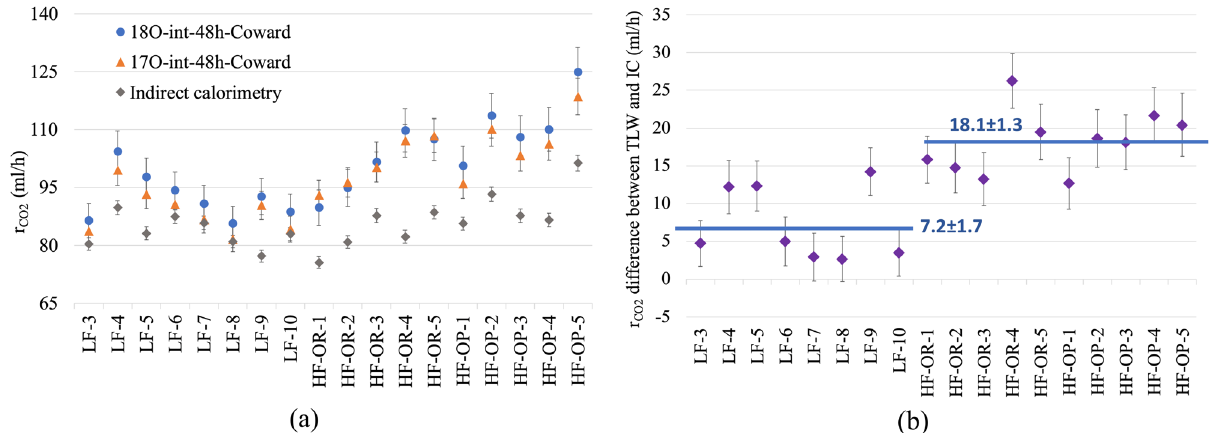
Figure 6. (a) Individual r CO2 values (ml/h) measured by 18 O– 2 H or 17 O– 2 H DLW using the Coward 1985 two-pools model by the intercept method at the 48 h finals. The blue points are the 18 O-based results, with 5.1% uncertainty, and the orange points are for 17 O with 4% uncertainty. The grey points are the individual indirect calorimetry vales for day two (2% uncertainty). (b) The difference between the r CO2 values calculated by the TLW and IC methods. The r CO2 values of the TLW method are the average the r CO2 ( 18 O) and r ′ CO2 ( 17 O) in ( a